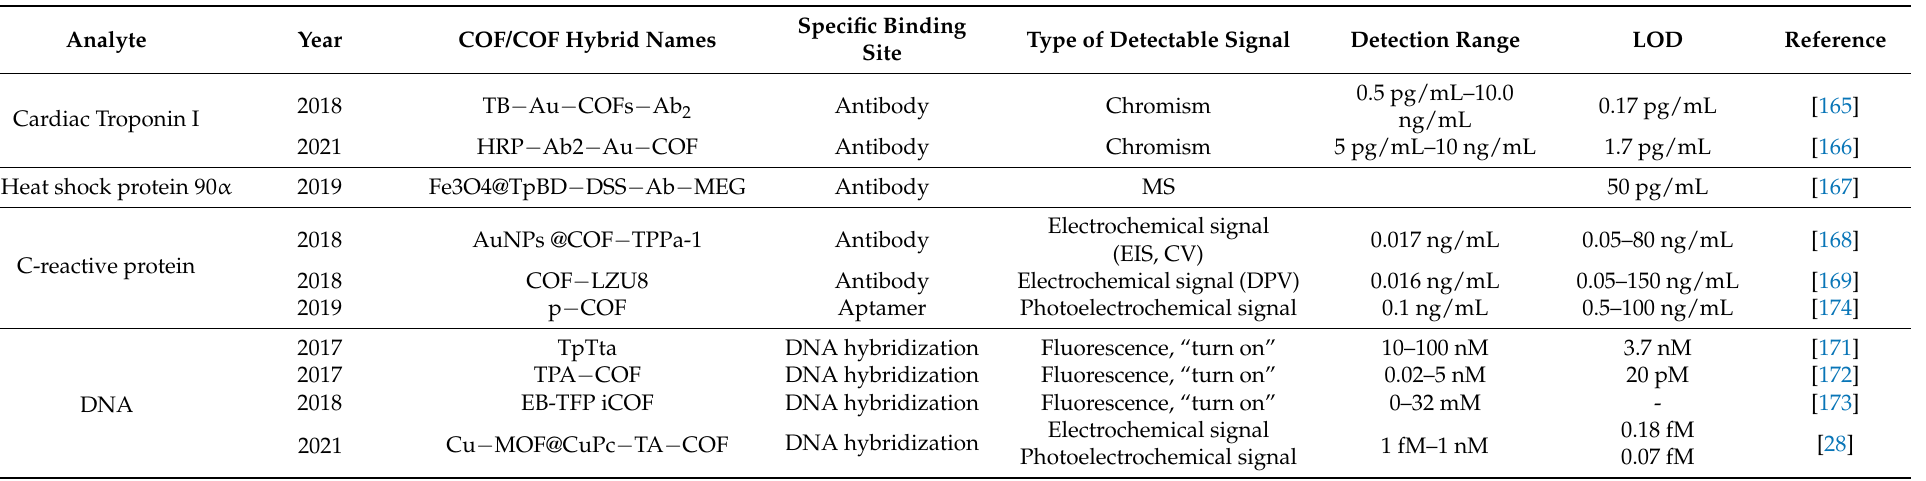
Table 9. COF-based sensing of some typical